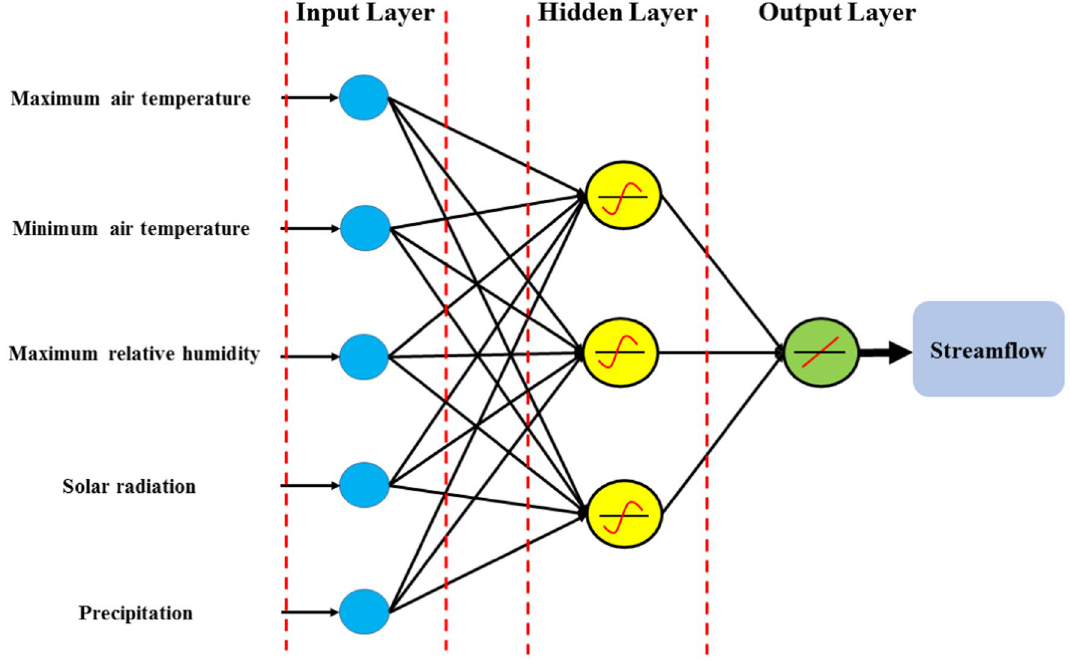
Fig. 3 Schematic diagram for the MLP model used in the current